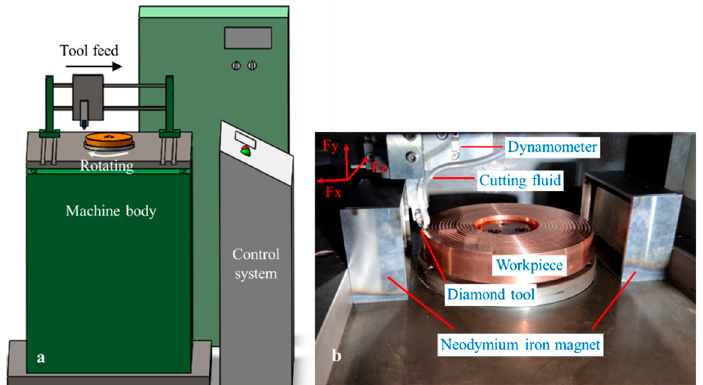
Figure 2. Single-point diamond-turning experiment, ( a ) machine tool, ( b ) magnetic-field-assisted turning.